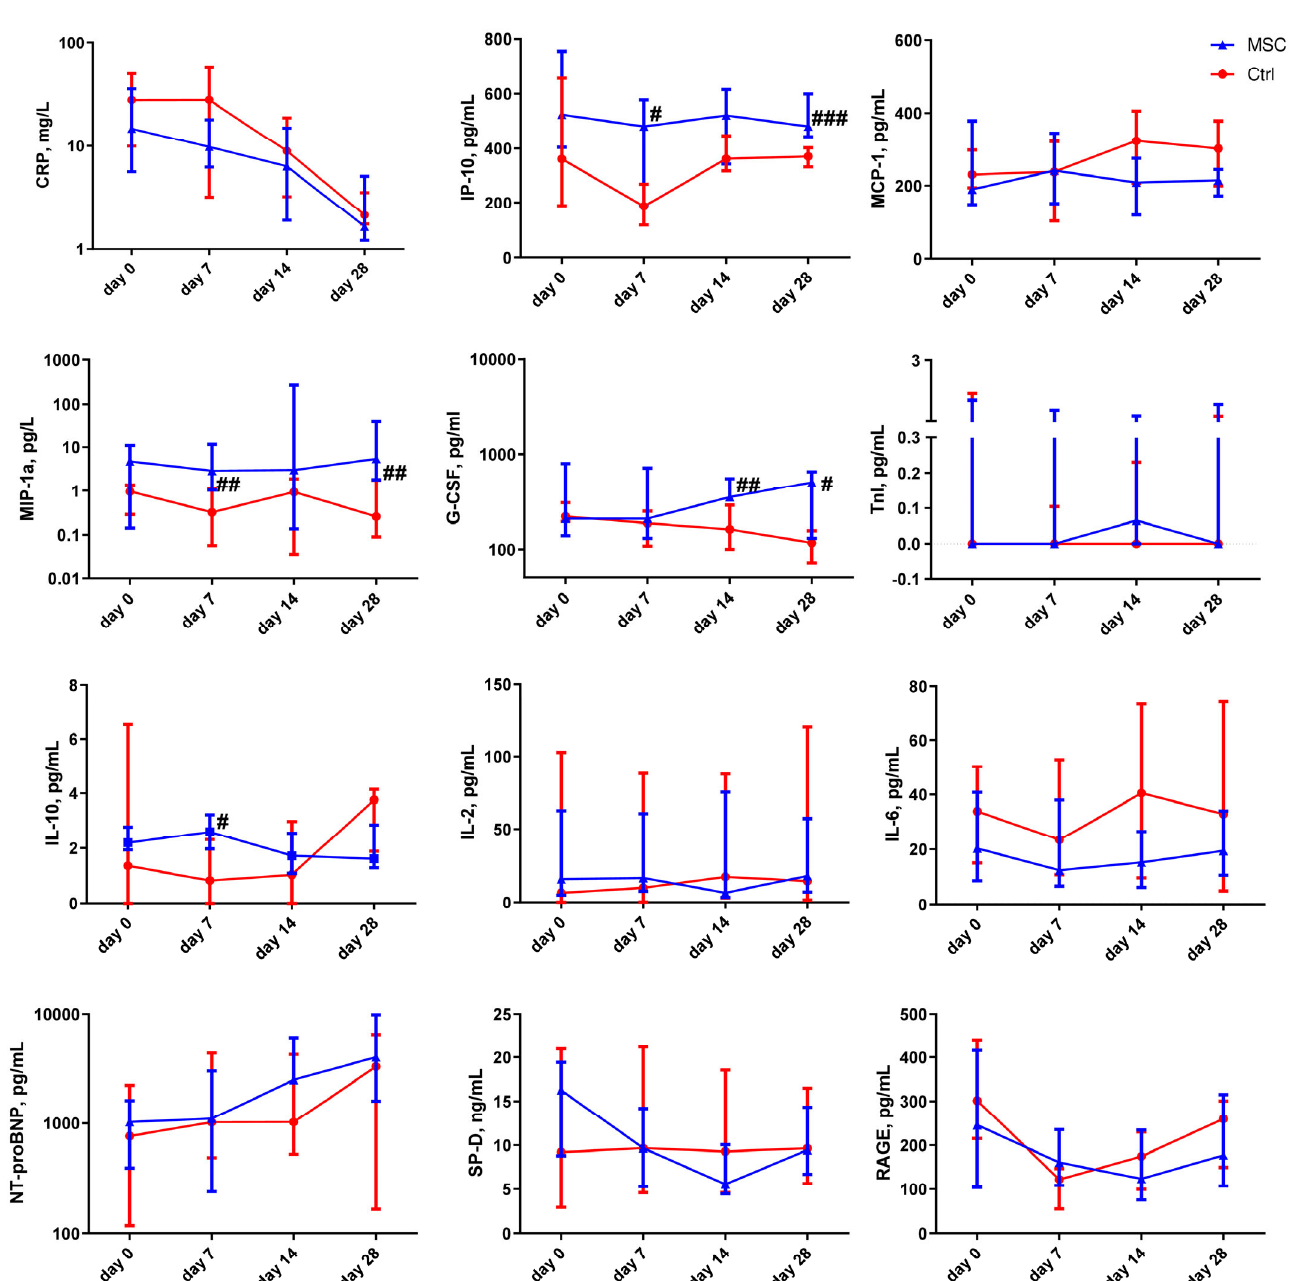
Figure 3. Dynamic changes in cytokine levels in patients with COVID-19. Data are presented as a median and interquartile range. Mann–Whitney U test for comparing the control and MSC groups at each time-point: #, p ≤ 0.05; ##, p ≤ 0.01; ###, p ≤ 0.001. The red line represents the Control group; the blue line represents the MSC group. CRP, C-reactive protein; IP-10, interferon gamma-induced protein 10; MCP-1, monocyte chemoattractant protein-1; MIP-1 α , macrophage inflammatory protein-1 alpha; G-CSF, granulocyte colony-stimulating factor; IL-10, interleukin 10; IL-2, interleukin 2; IL-6, interleukin 6; NT-proBNP, N-terminal prohormone of brain natriuretic peptide; TnI, troponin I; SP-D, surfactant D; RAGE, receptor for advanced glycation endproducts.